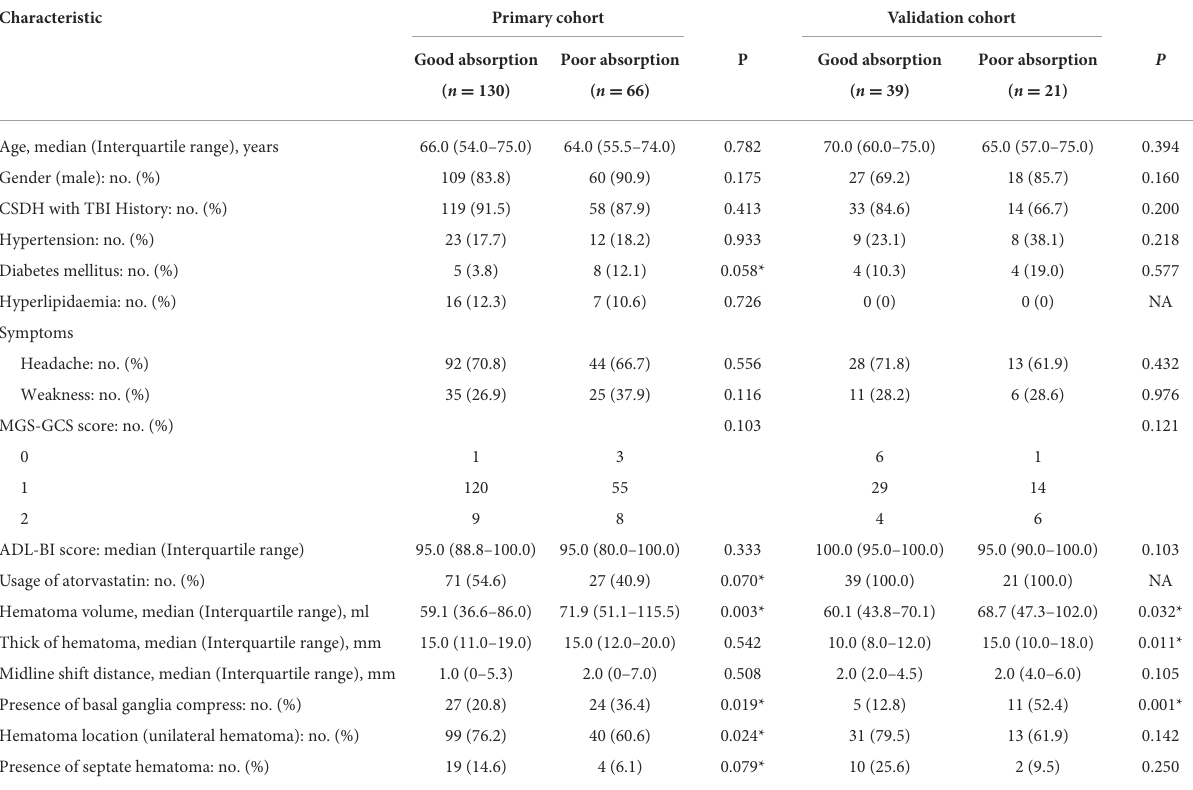
TABLE 1 Characteristics of patients with chronic subdural hematoma (CSDH) in the primary and validation cohorts. Characteristic Primary cohort Validation